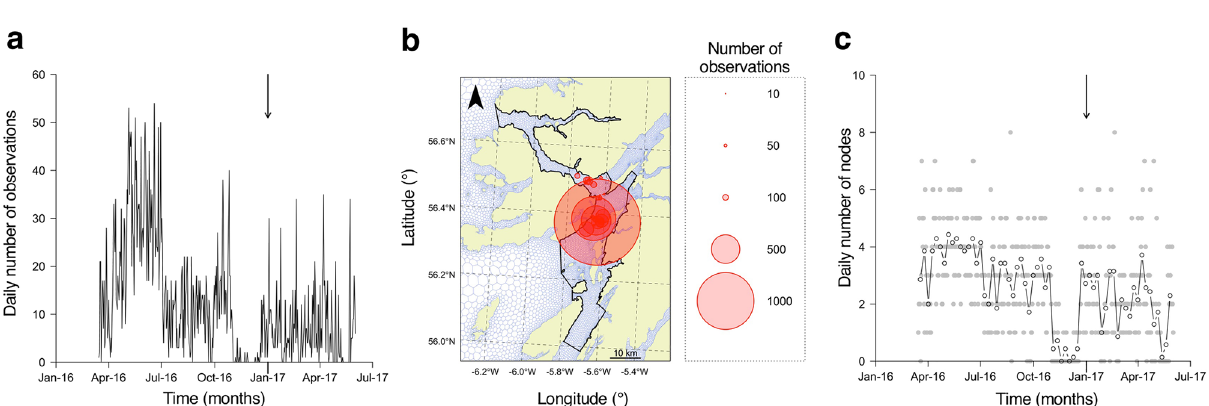
Figure 3. Bottom-temperature validation effort. ( a ) Temporal effort, expressed as the number of observations per day through time. The arrow marks the transition from 2016 to 2017; observations before and after this transition span a critical window when the model was independently upgraded. ( b ) Spatial effort, expressed as the number of observations at each receiver location. Map properties follow Fig. 1. ( c ) Spatiotemporal effort, expressed as the number of nodes with observations per day through time. The filled grey points show the number of nodes for each time step (hour); the open points and the line mark the weekly